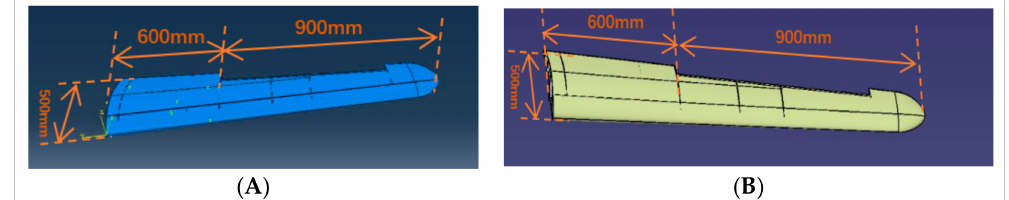
Figure 9. The finite element (FE) model and the CAD model of the variable section wing. ( A ) The FE model; ( B ) The CAD model.